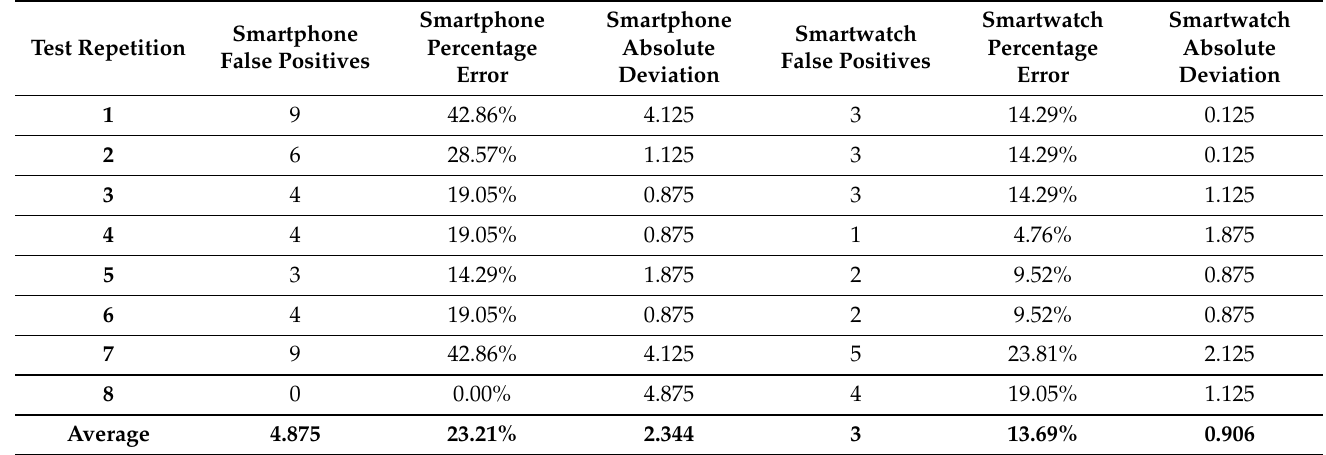
Table 2. Test 2. Percentage error and false positives.